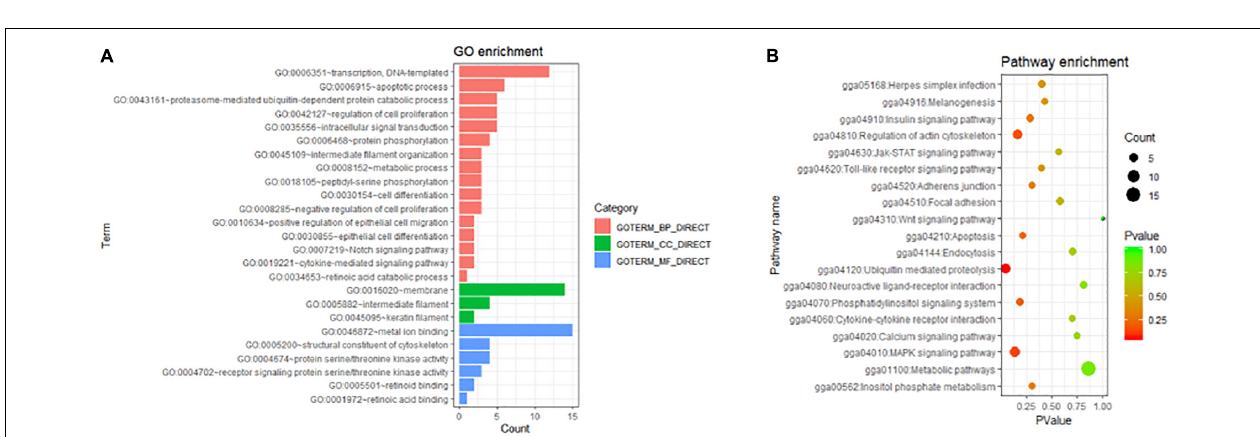
FIGURE 3 | The expression divergences of SPEF2 (A,C) and PRLR (B,D) between EF and LF Shouguang chicks at one-old age. EF means the early-feathering Shouguang chick group, LF means the late-feathering Shouguang chick group. Panels (A,B) were plotted based on RNA sequencing analysis; Panels (C,D) were plotted based on the results of quantitative real-time PCR. ****means the values of gene relative expression levels are significantly different between the EF and LF groups at the P < 0.0001 level.